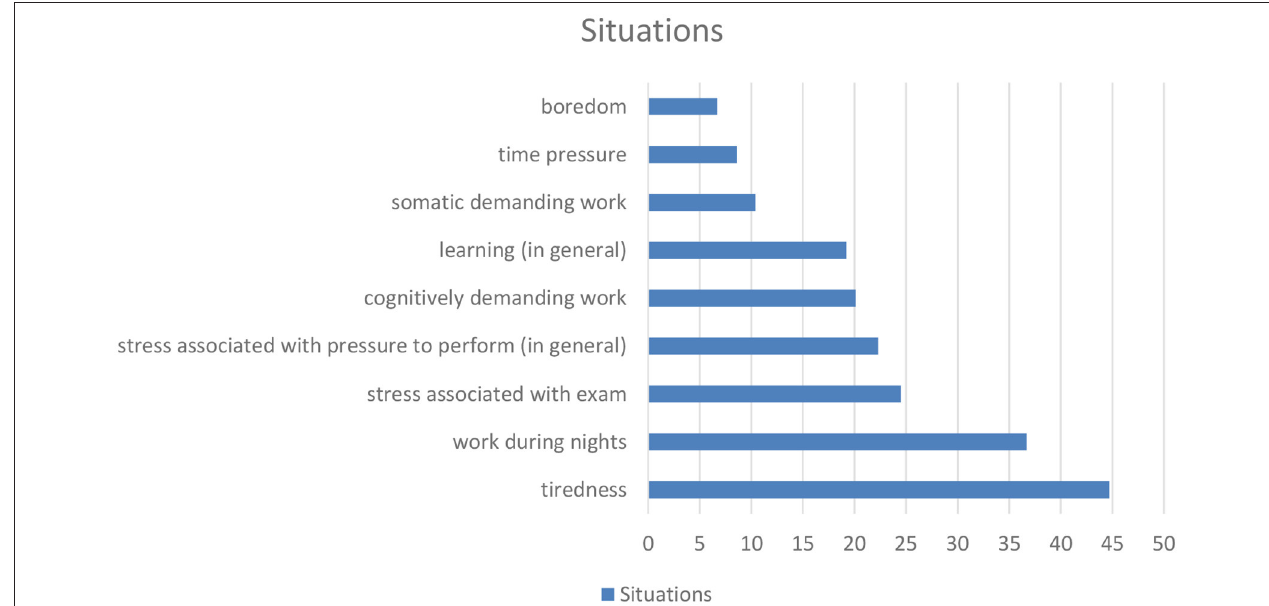
FIGURE 1 | (According to Table 6 ): Situations of the use of methylxanthines for neuroenhancement.